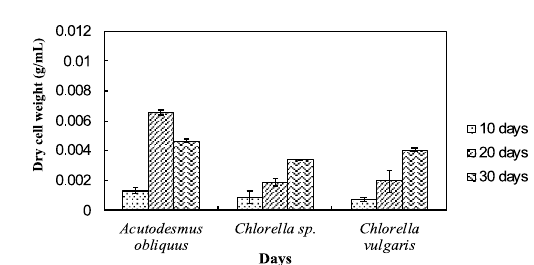
Fig. 1b. Dry cell weights of microalgae in nitrogen enrich medium.